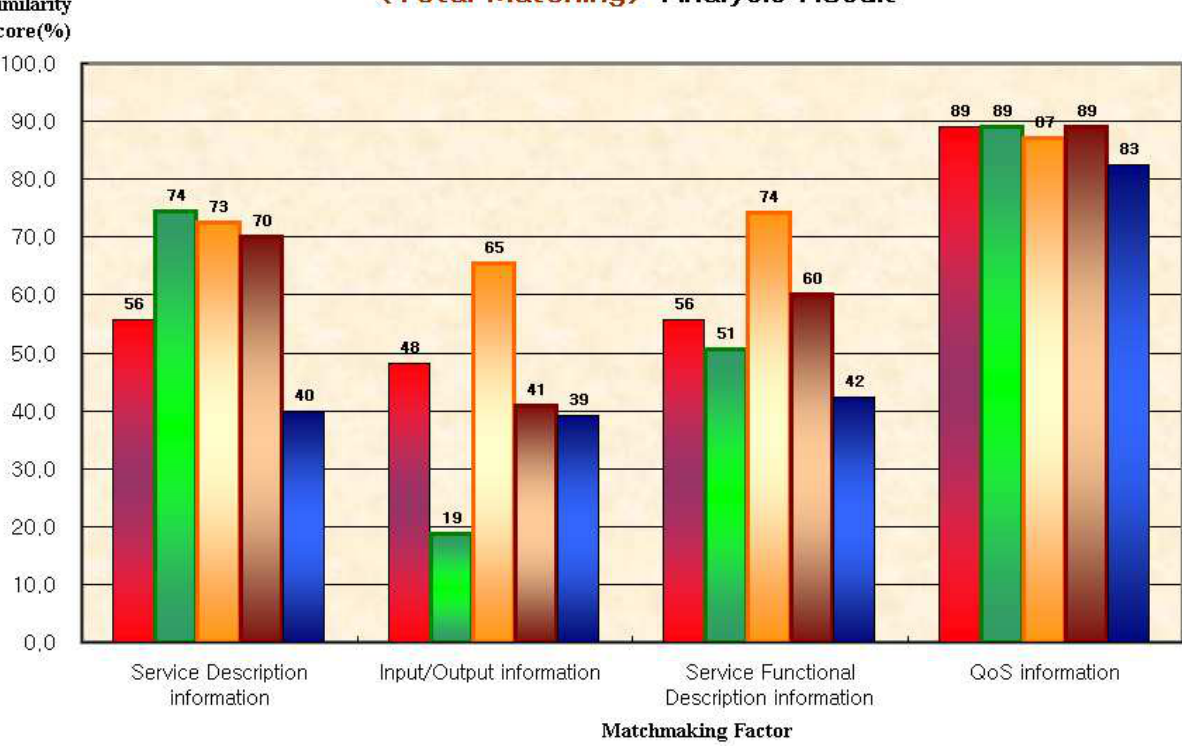
Figure 9. Total matching